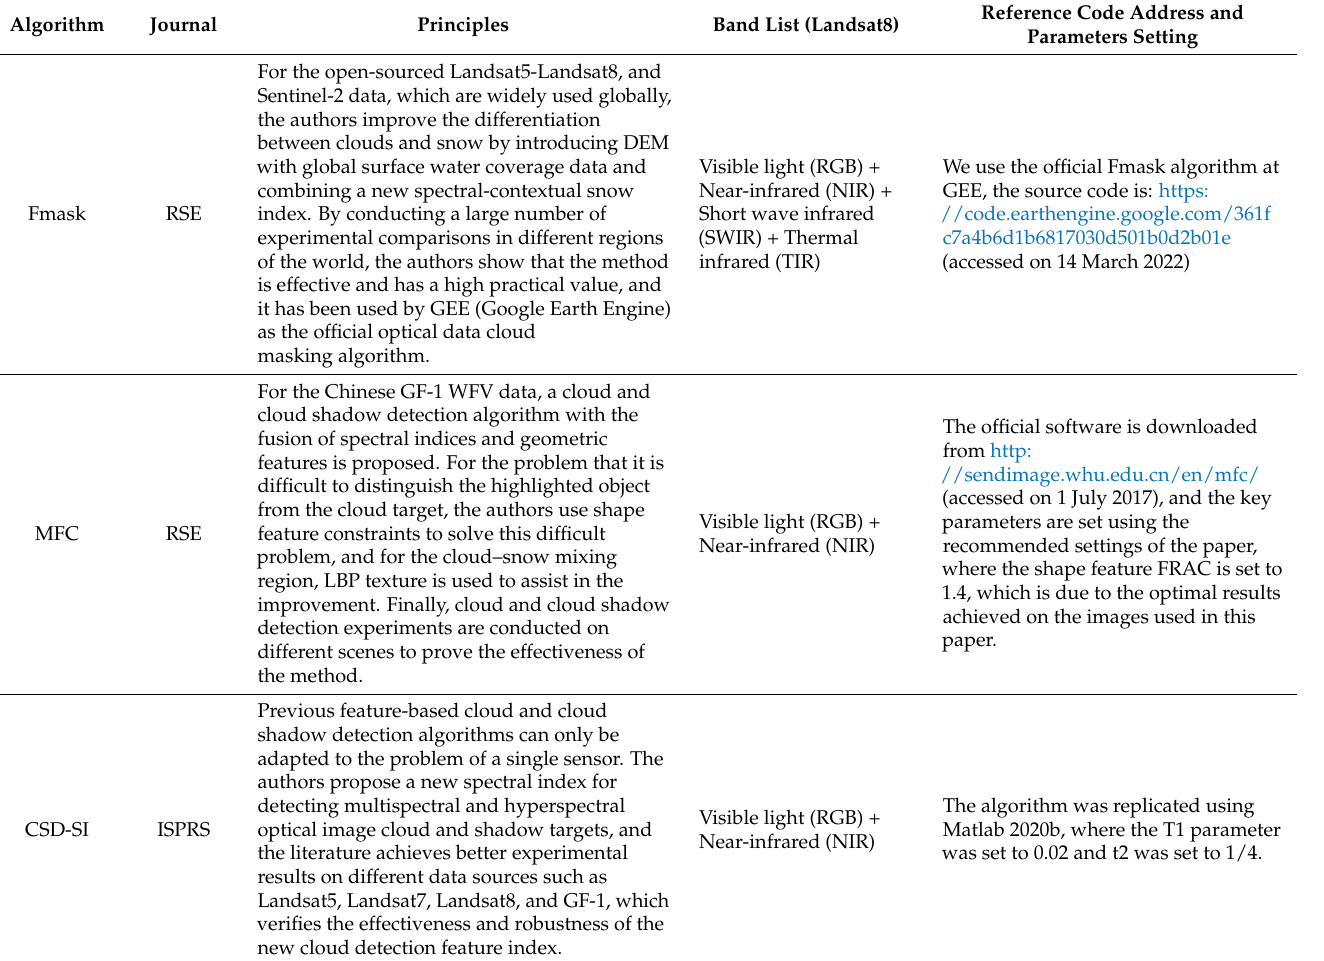
Table 3. Comparison of different feature-based